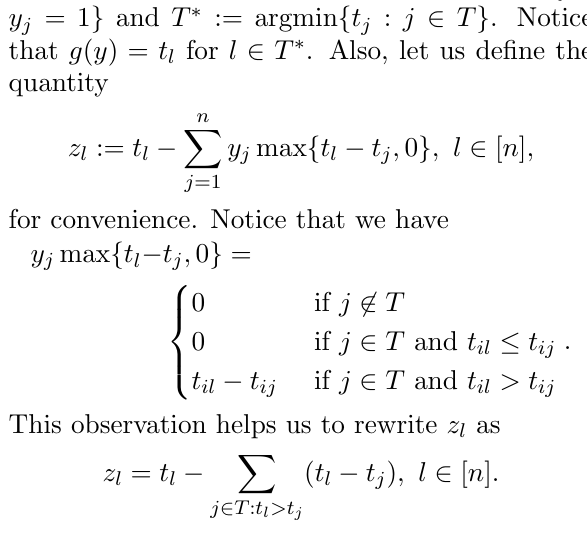
Algorithm 2. Input: A probability